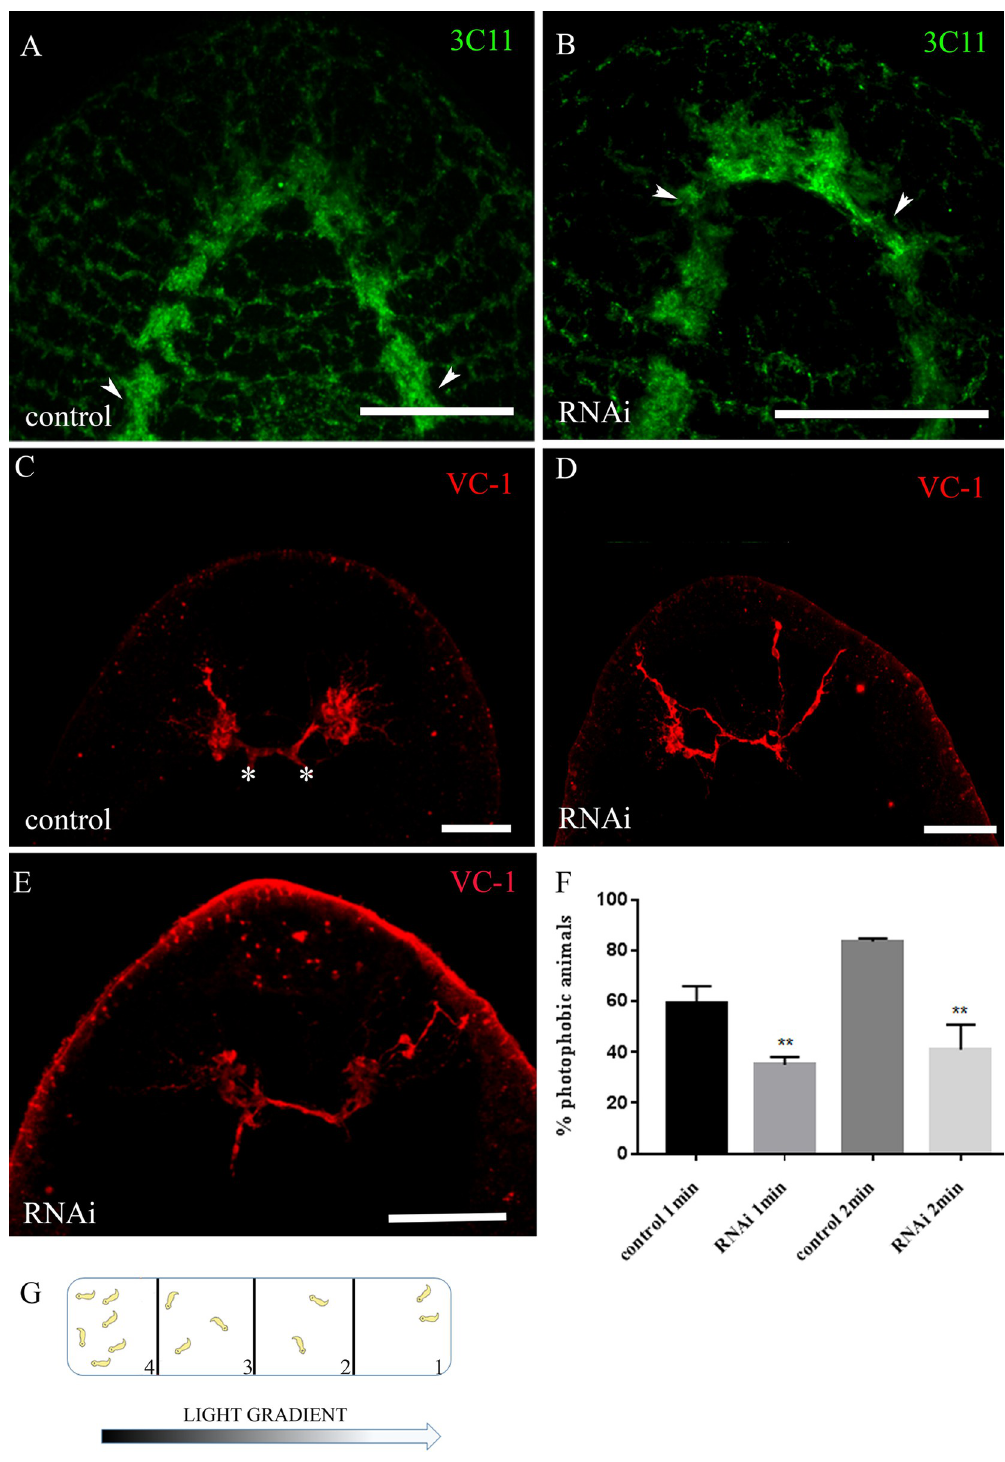
Fig 6. Analysis of the nervous system in DjMap1B -silenced animals. (A) Representative confocal images of 3C11 expression in a control head fragment and (B) DjMap1B -silenced (RNAi) head fragment 7 days after amputation. Cephalic ganglia with U-inverted shapes are indicated by arrowheads. (C) Representative confocal images of VC-1 distribution in a control tail fragment and (D, E) in DjMap1B silenced (RNAi) tail fragment 7 days after amputation. Asterisks indicate the medial region of the brain where visual neurons projected from the optic chiasm. (F) Graph depicting the percentage of